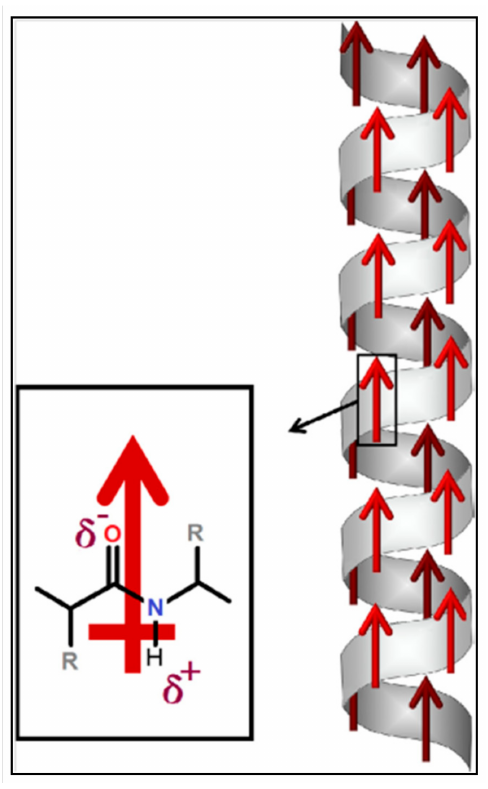
Figure 2. Piezoelectric mechanisms involving crystal lattice deformations in ceramic materials: ZnO atomic model and different piezoelectric potential under either compression or tension. Reprinted with permission from [36].